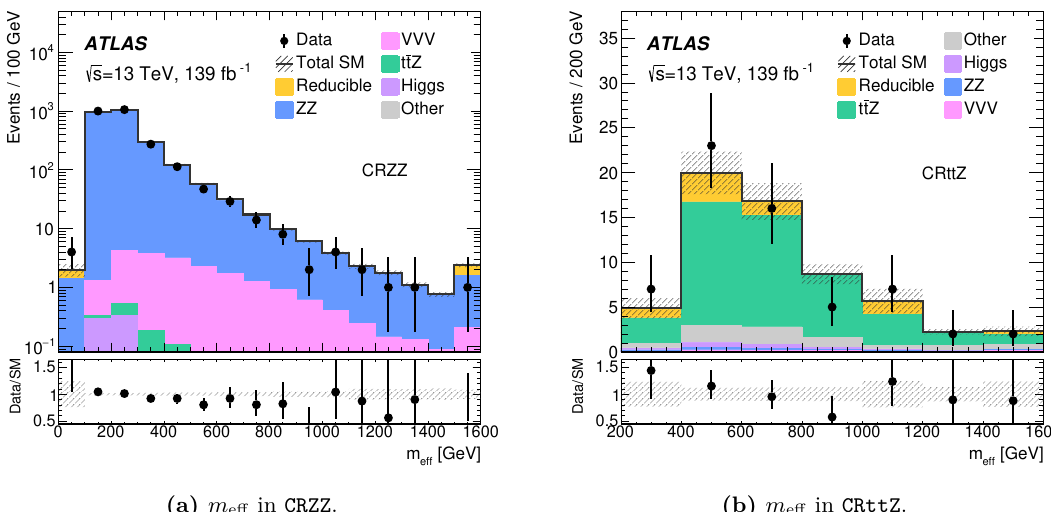
Figure 3. The m eff distributions for data and the SM backgrounds in CRZZ and CRttZ after the background-only fit. “Other” is the sum of the tWZ , t ¯ tWW , t ¯ tZZ , t ¯ tWZ , t ¯ tWH , t ¯ tHH , t ¯ ttW , and t ¯ tt ¯ t backgrounds. The last bin includes the overflow. The lower panel shows the ratio of the observed data to the expected SM background yield in each bin. Both the statistical and systematic uncertainties in the SM background are included in the shaded